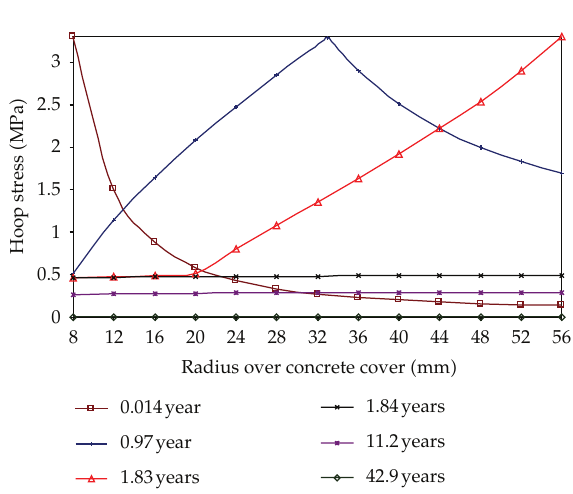
Figure 11: Hoop stress (cid:5) σ θ (cid:6) varying over concrete cover at various times.